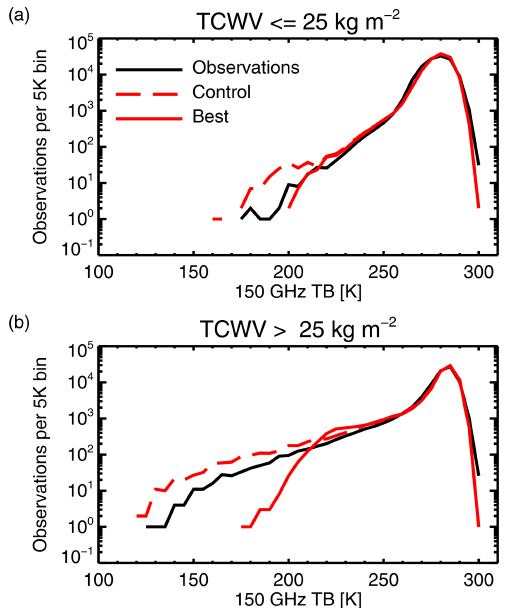
Figure 8. Histograms of SSMIS 150h brightness temperatures over land surfaces (greater than 0.5 land fraction): (a) locations with less than or equal to 25kgm − 2 total column water vapour (TCWV, ap- proximately 125000 observations); (b) locations with more than 25kgm − 2 TCWV (approximately 81000 observations).